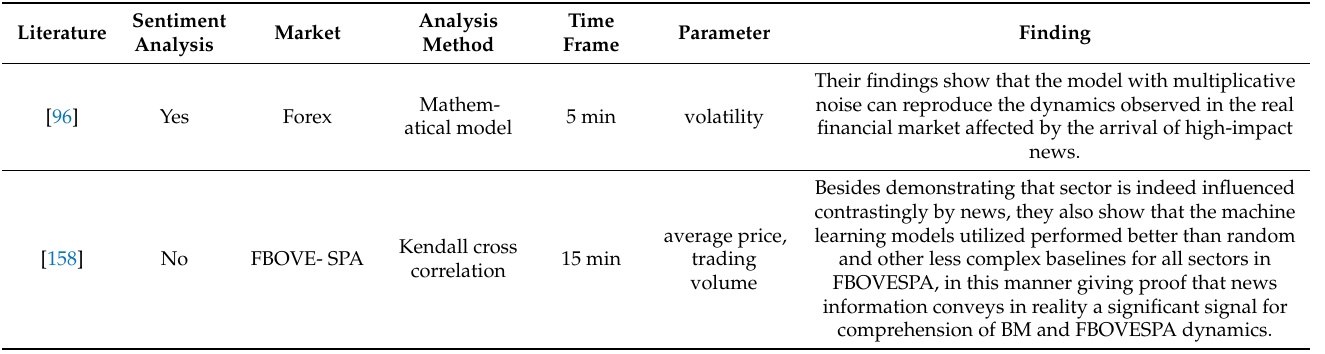
Table 6. Findings in behavior analysis